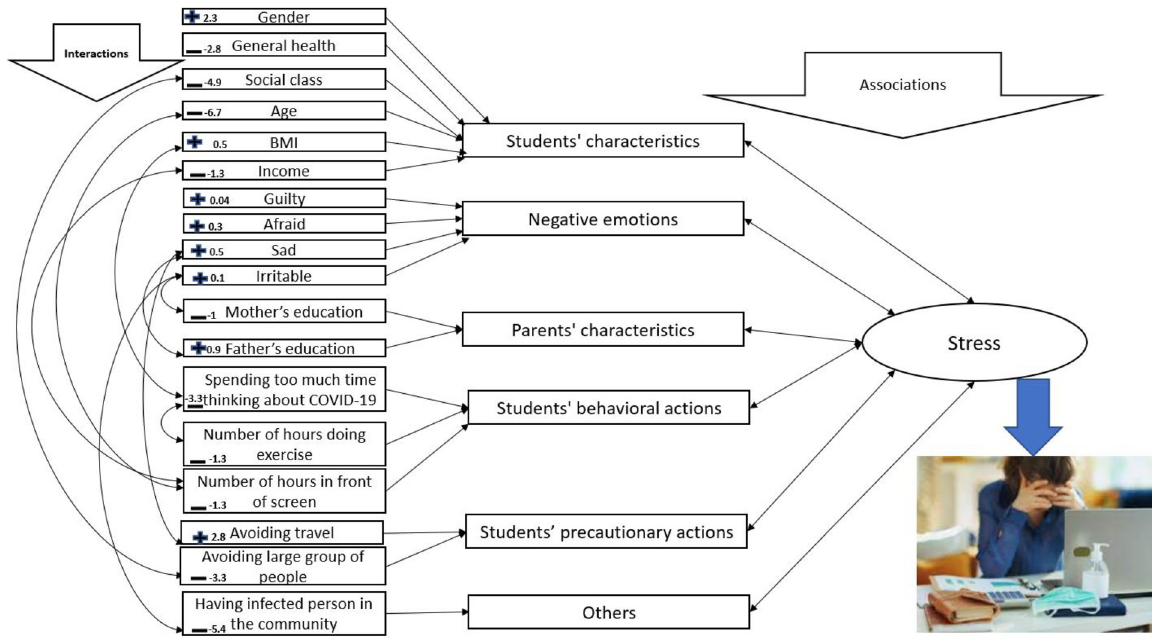
Fig 1. Summary of the complex relationships between college students’ stress from the COVID-19 pandemic (left hand side) and associations with myriad factors (right hand side); positive and negative signs show whether associations with more stress are positive or